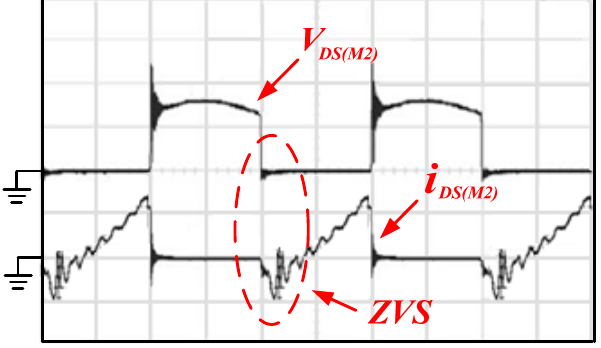
Figure 17. Measured voltage and current waveforms of switch M : 2 A/div; time : 5 i DS